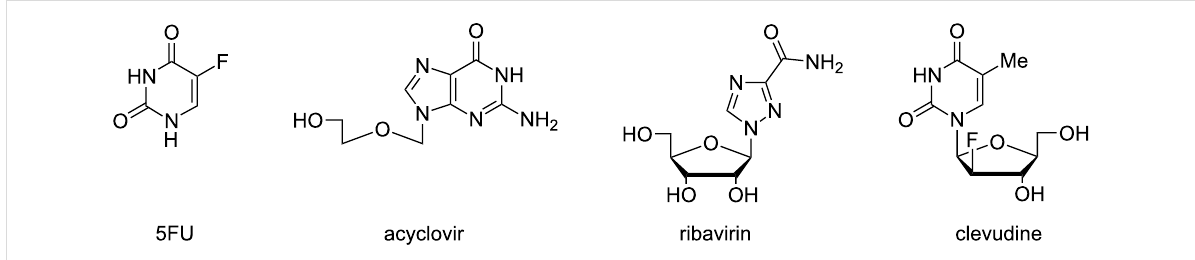
try range either under dry conditions or in the presence of a variety of organic solvents [83]. Liquid-assisted grinding of mixtures containing 50–90 mol % 5FU at 30 Hz for 30 min gave homogenised solid solutions using two drops of aceto-